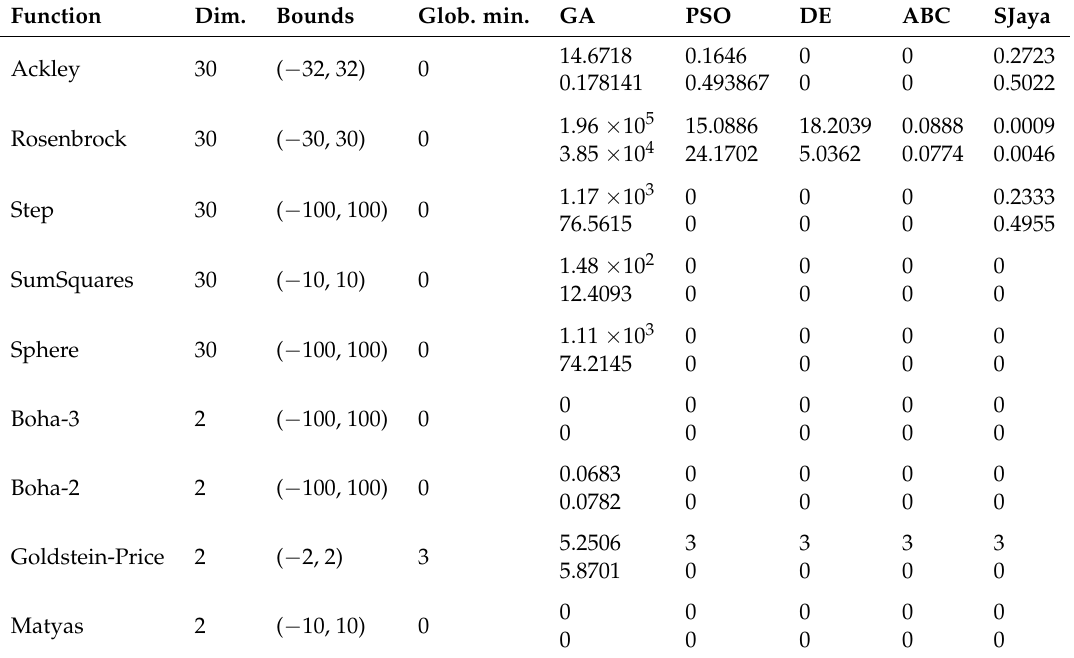
Table 14. Comparative performance: mean and standard deviation of 30 best-of-run fitnesses. For each function, the top row shows the means and the bottom row the standard deviations (results are rounded at the fourth decimal